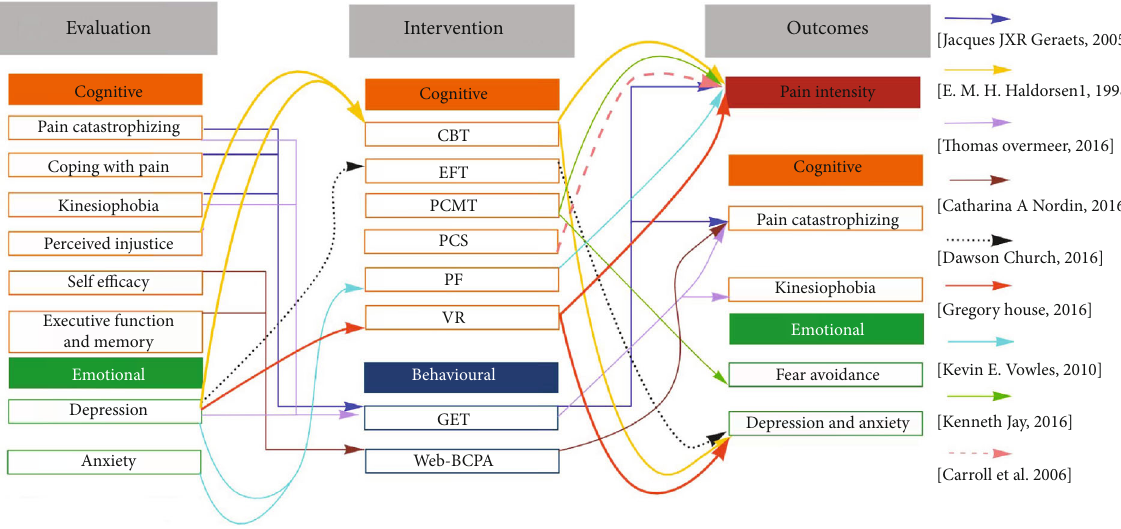
Figure 5: Mapping of the available evidence on usage of the psychological factors in evaluation and treatment of the patients with persistent shoulder and neck pain. Each arrow indicates each study and shows the psychological aspects they targeted in their evaluation, treatment, and